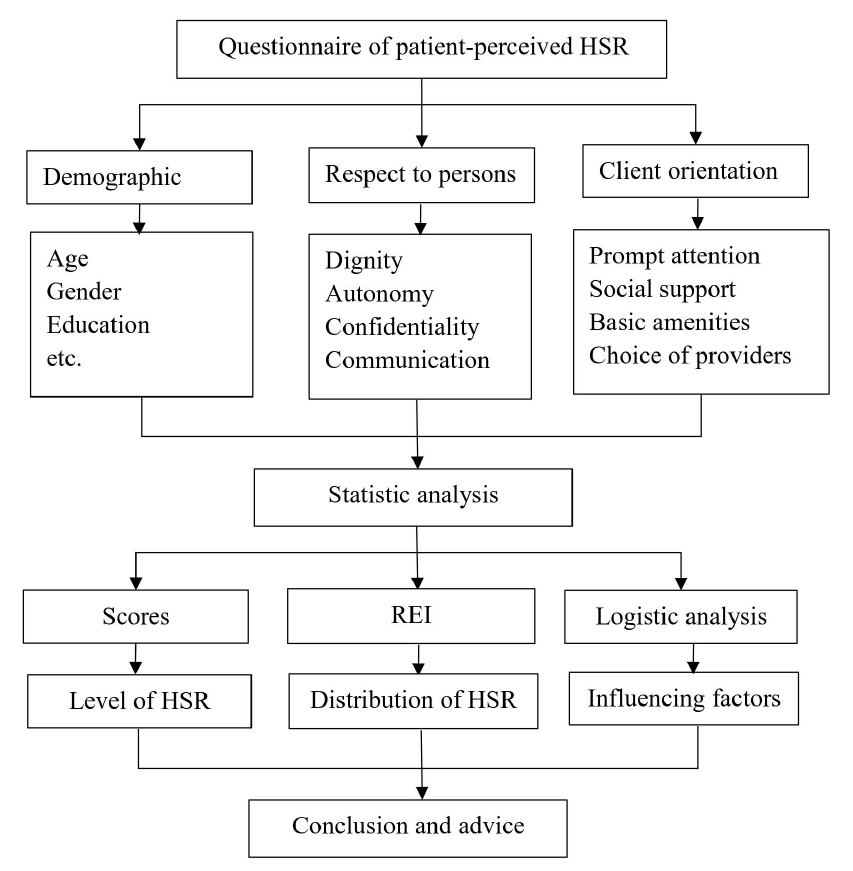
Figure 1. The framework of responsiveness evaluation.